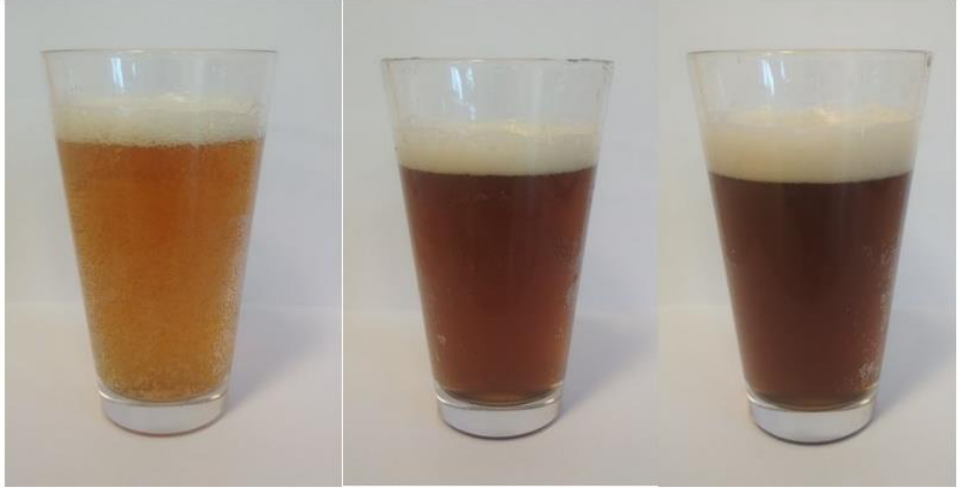
left: CB — control beer, AB0 —cv. ‘Amela’ with ozone -treated fruit and AB1 — untreated fruit.